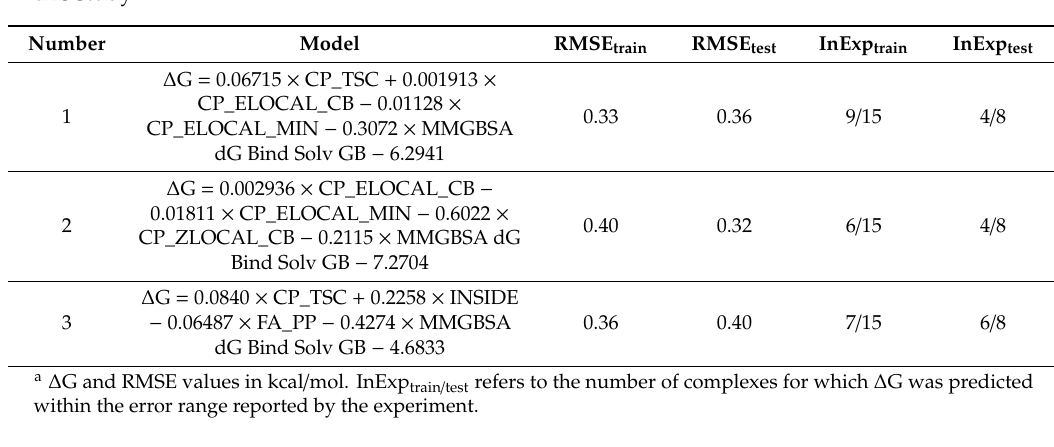
Table 1. Best performing four-descriptor models predicting Wnt-Fzd CRD binding energy obtained in this study a .